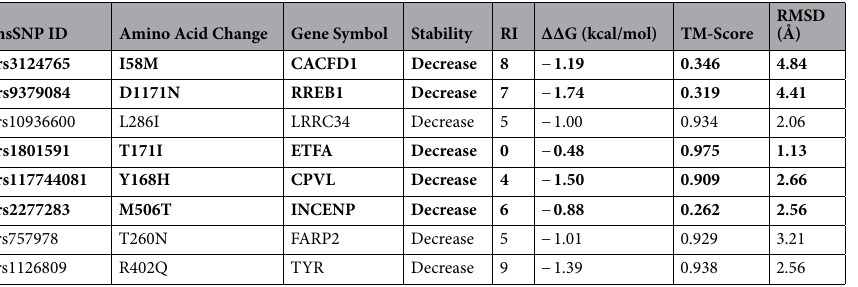
Table 5. I-Mutant 3.0 and TM-align predictions for nsSNPs associated with cancers among the Orang Asli and Malays. RI = Reliability Index. RMSD = Root Mean Square Deviation. ΔΔG ≤ − 0.5 kcal/mol = destabilizing mutations, ΔΔG ≥ 0.5 kcal/mol = stabilizing mutations, − 0.5 kcal/mol ≤ ΔΔG ≤ 0.5 kcal/mol = neutral mutations. 0.0 < TM-score < 0.30 = random structural similarity, 0 ± 0.3 and 0.5 < TM-score < 1.00 = in about the same fold 0.5 ± 1. Highlighted rows are the excluded